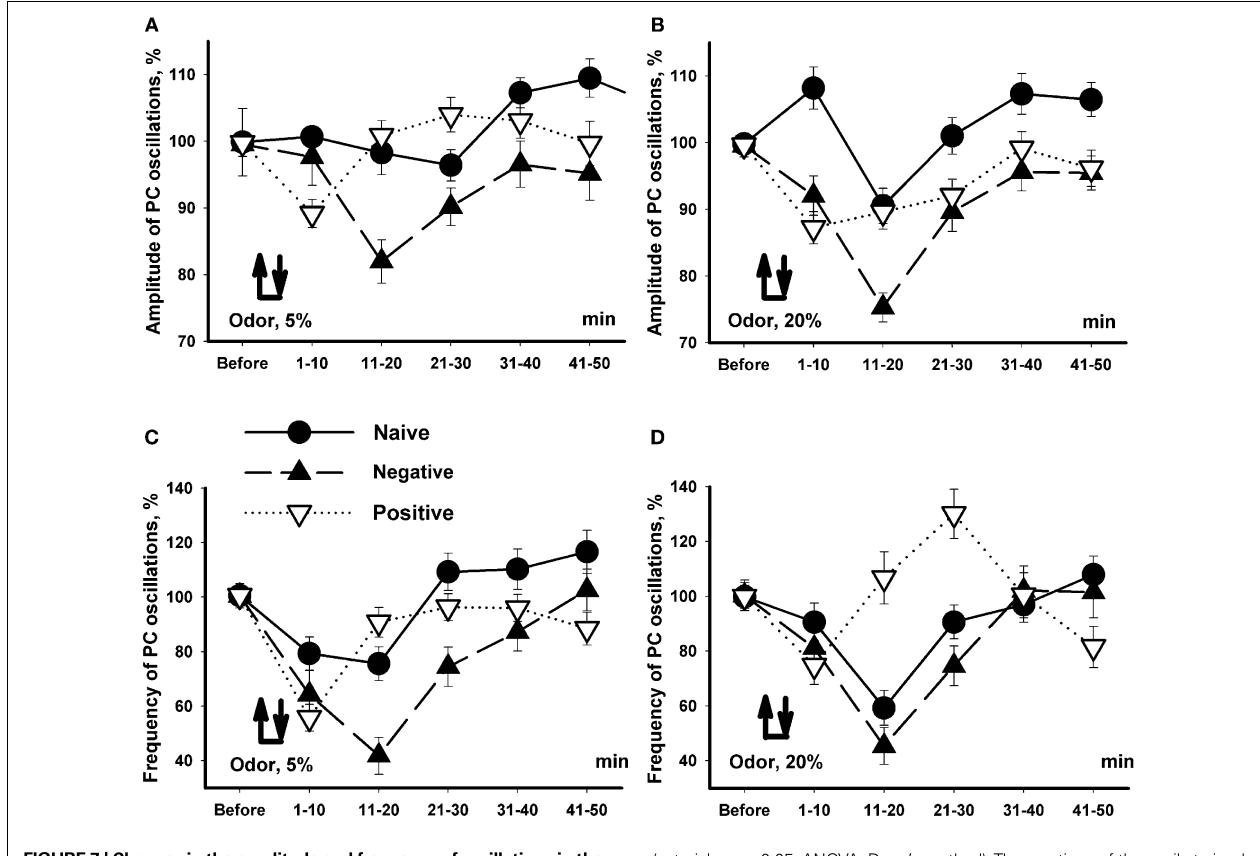
(asterisks, p < 0.05, ANOVA, Dunn’s method). The reactions of the snails trained to respond with aversive or feeding reaction to cineole were signifi cantly